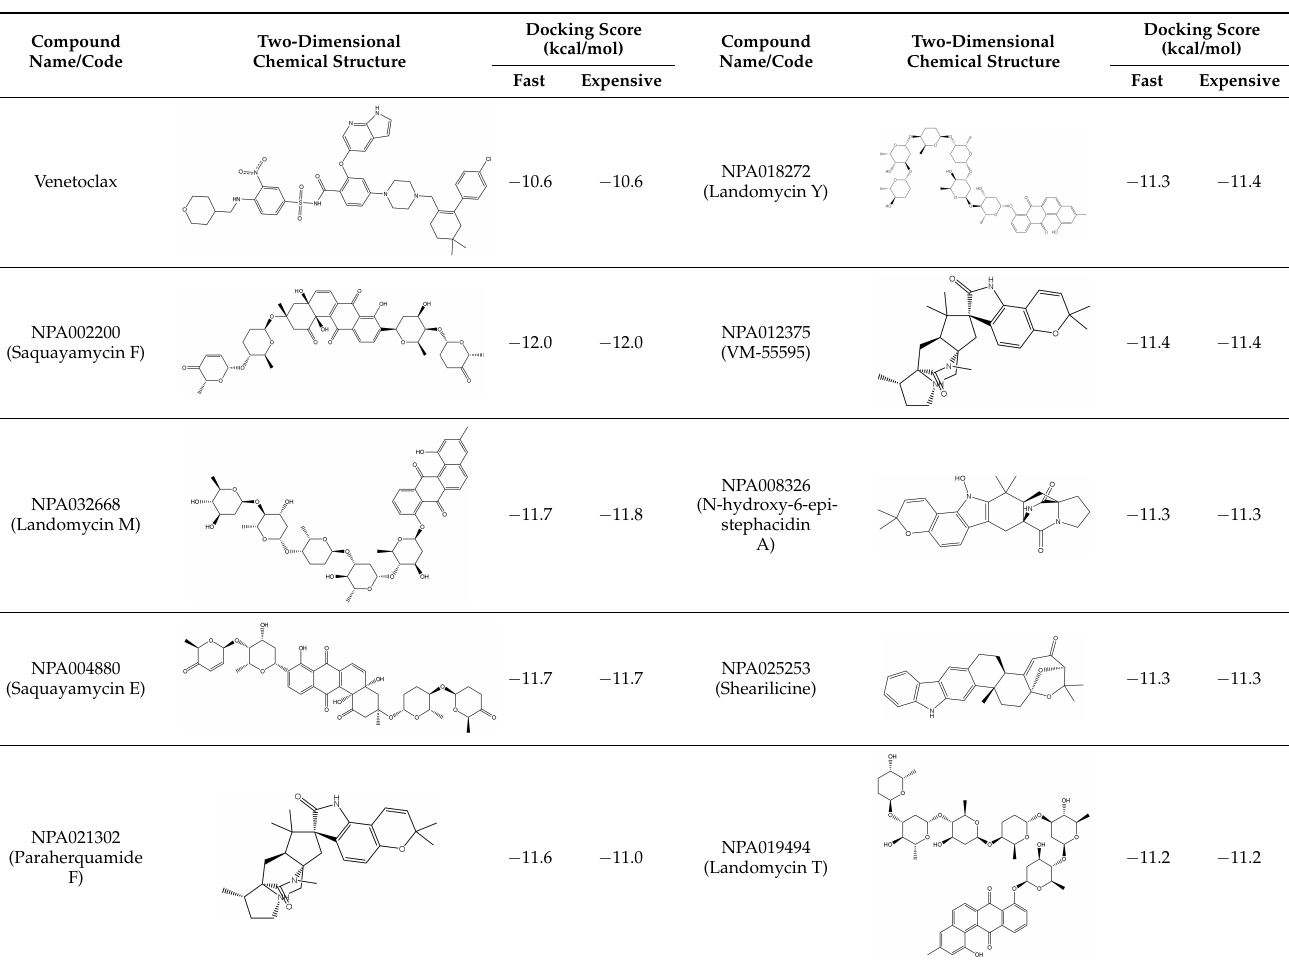
Table 1. Two-dimensional chemical structures and expected fast and expensive vina docking scores (in kcal/mol) for the top 42 potential NPAtlas compounds against the Bcl-2 protein compared to venetoclax a